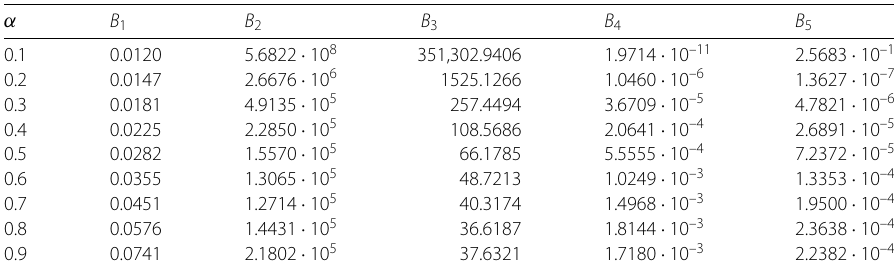
Table 2 Explicit constants for Example